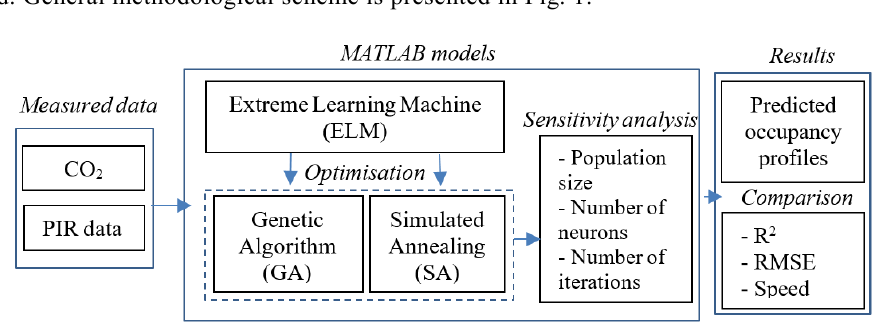
Fig. 1. General methodological